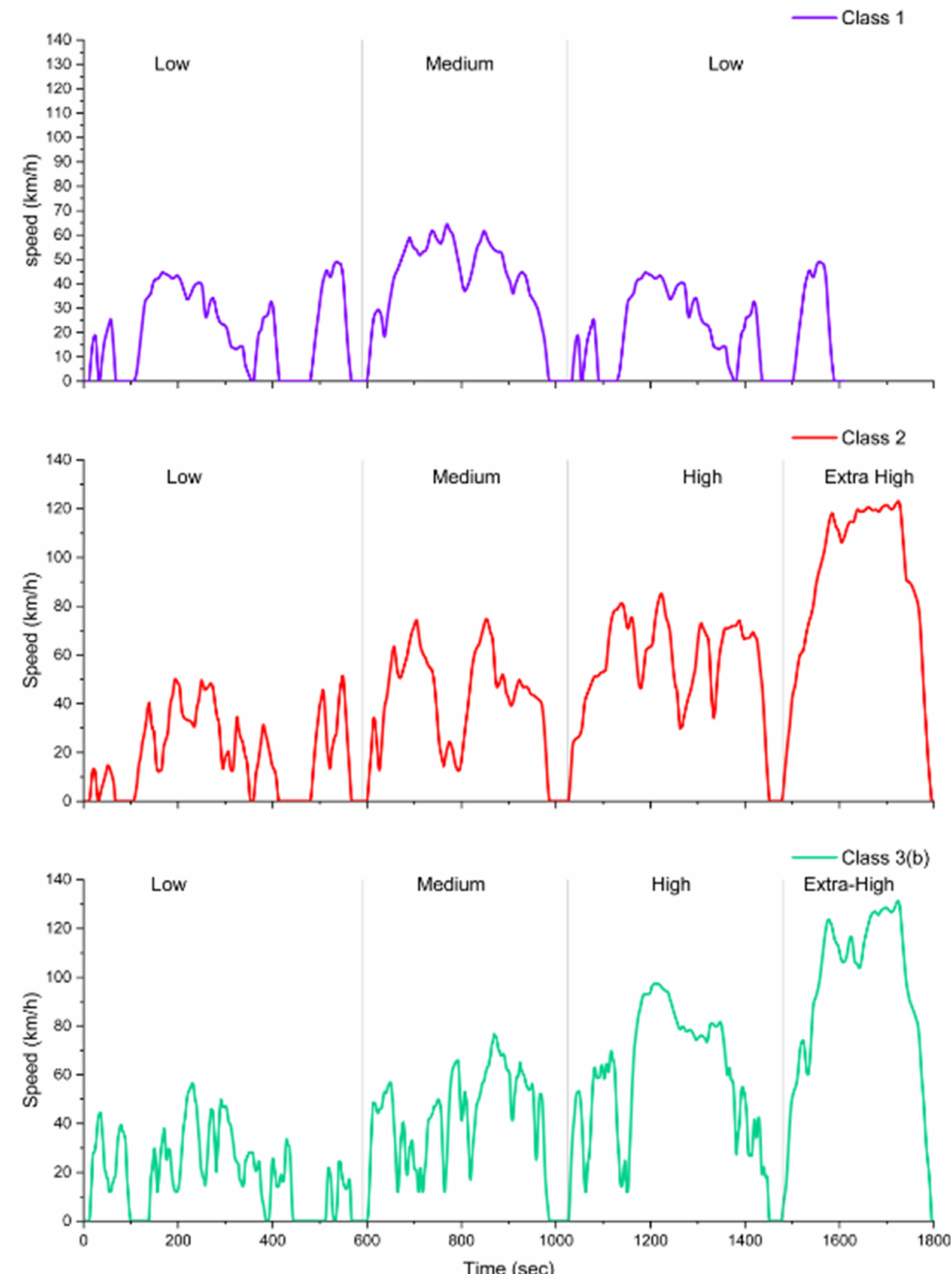
Figure 11. WLTC cycle for Class 1, Class 2 and Class 3(b)